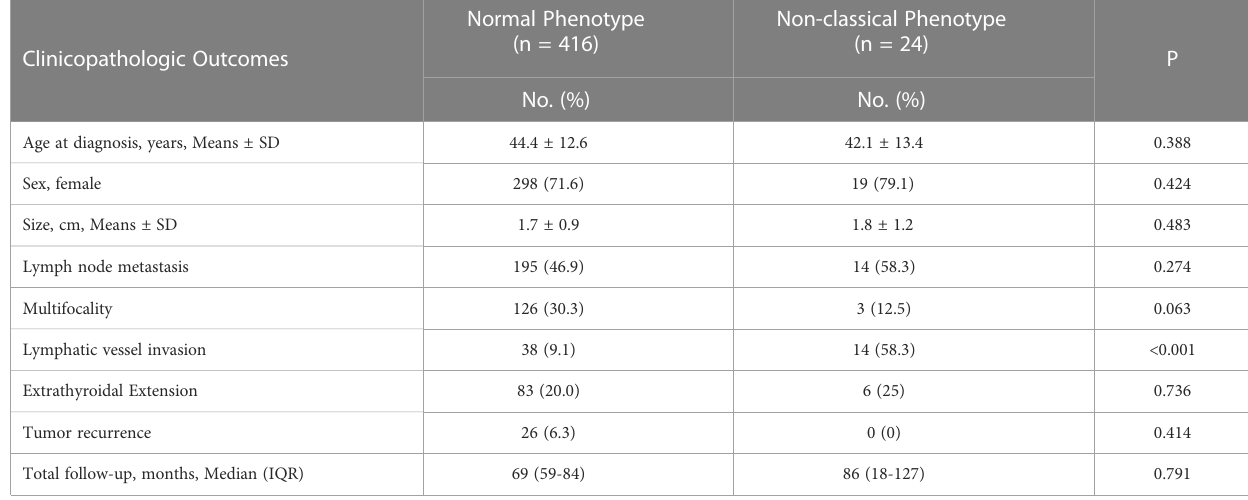
TABLE 1 Relationship of the non-classical phenotype group with clinicopathologic